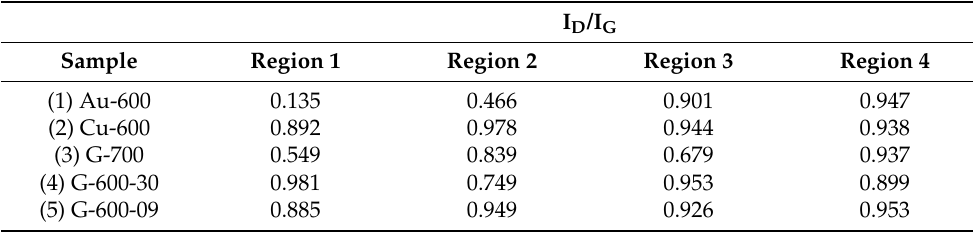
Table 2. Peak intensity ratios of the D and G bands of graphite (I D /I G ).